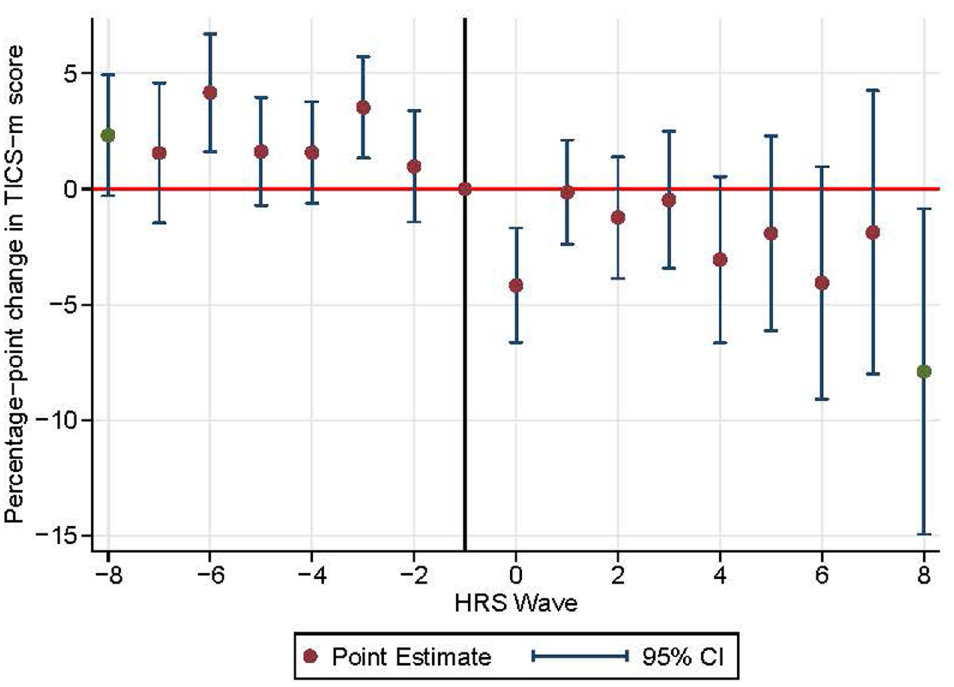
Fig 2. Event study plot for overall